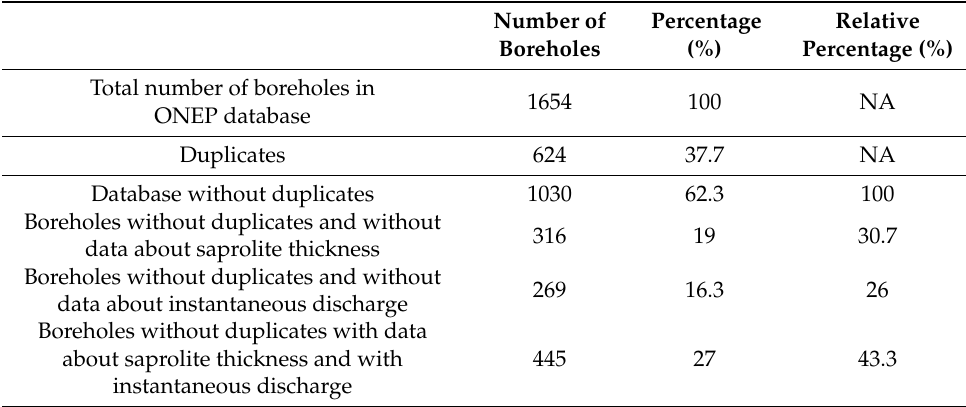
Table 2. ONEP database of boreholes used in this